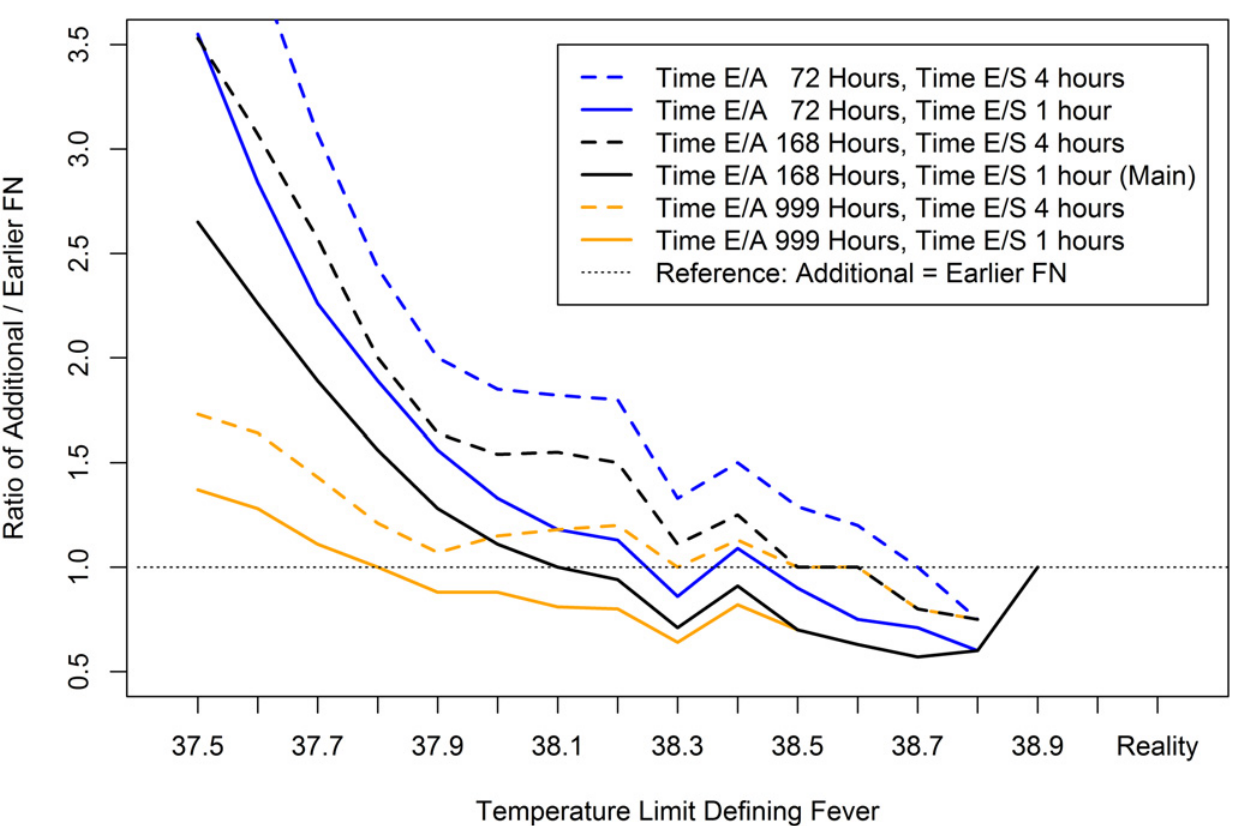
Figure 4. Ratio of additional/earlier FN diagnoses according to TLDF and definition of earlier FN diagnosis. Time E/A, time limit differentiating earlier versus additional FN. Time E/S, time limit differentiating earlier versus simultaneous FN.